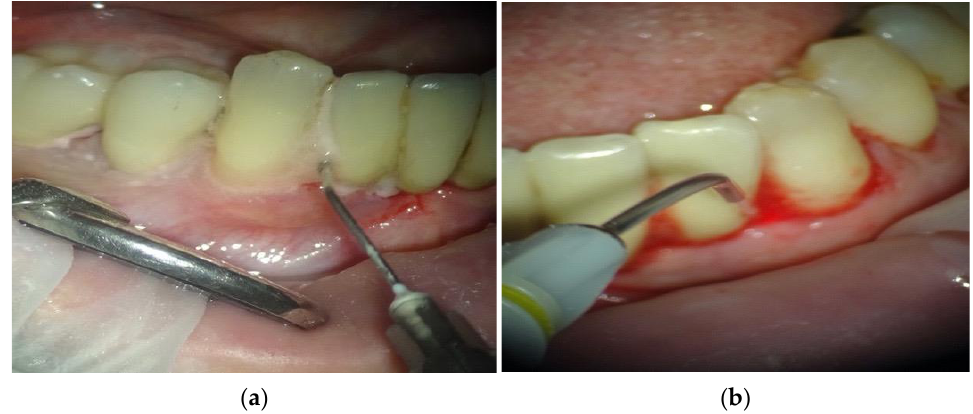
Figure 4. Photodynamic therapy without dye ( a ) Periodontal pockets irrigation with sioxyl solution; ( b ) Radiation with diode laser.